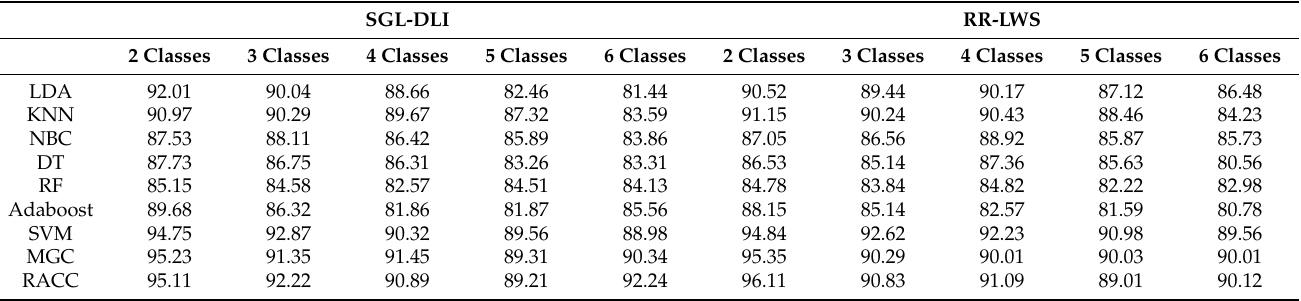
Table 5. Hierarchical clustering with